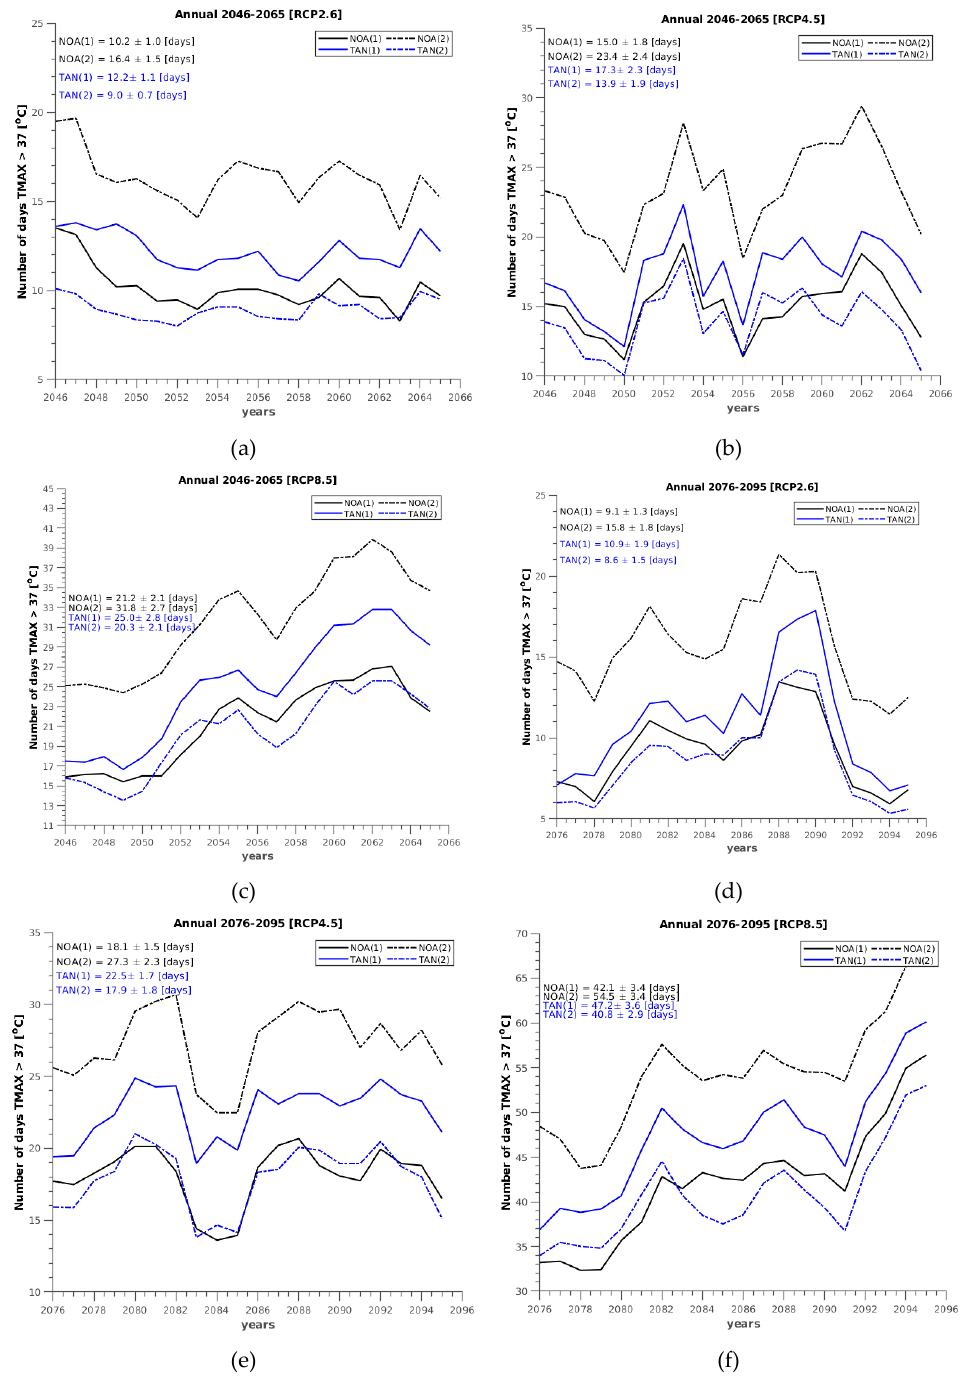
Figure 10. ( a – f ): Annual frequency of extremely hot days (T max > 37 °C) for the near and distant future periods (2046–2065 and 2076–2095) under climate scenarios RCP2.6, RCP4.5, and RCP8.5. For each period and scenario, simulations NOA (1)/TAN (1) are calibrated against the first reference period (1976–1995) under UHI regime UHI_1 and simulations NOA (2)/TAN (2) are calibrated against the second reference period (1996–2015) under UHI regime UHI_2. Averaged mean change in the frequency with respective confidence interval is given in the figures for each projection.